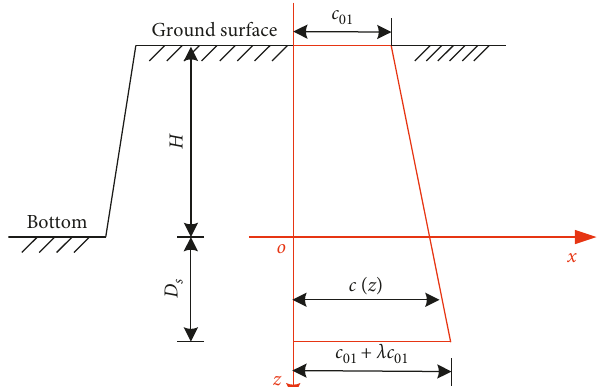
Figure 4: Nonhomogeneity of soil